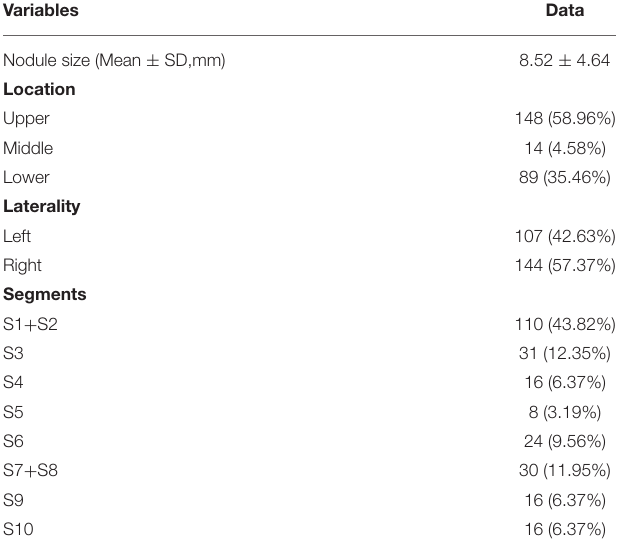
TABLE 2 | Nodules characteristic ( n = 251).